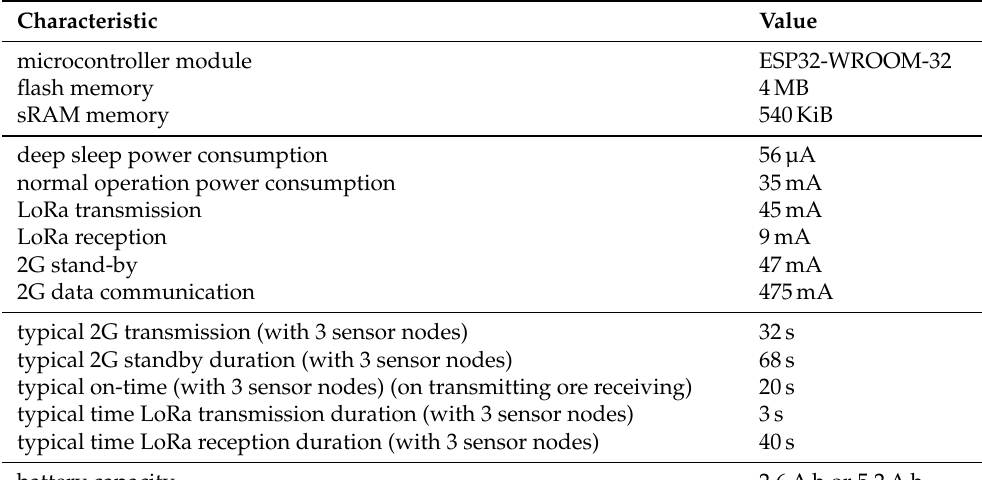
Table 2. Most important technical specifications of the MIRRA gateway (measured at an ambient temperature of